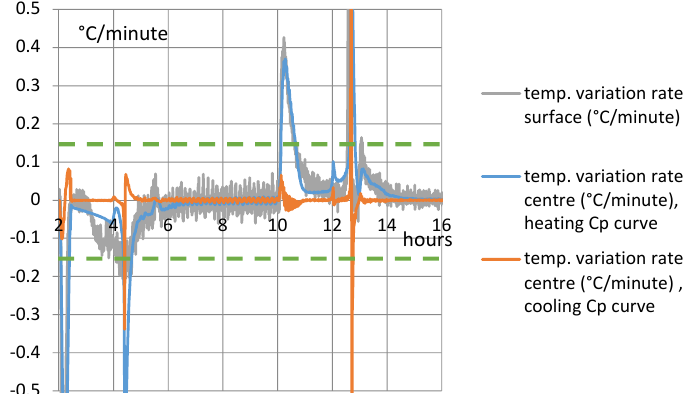
Figure 19. Rate of temperature variation at the centre of the container. Heating case with cooling c p curve.